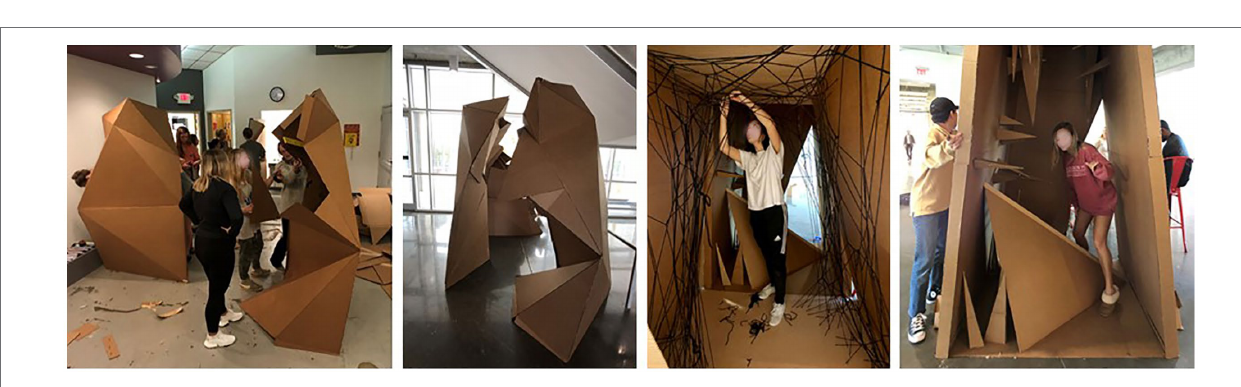
FIGURE 9 | Full-scale prototyping. Photo credit: Jain Kwon.